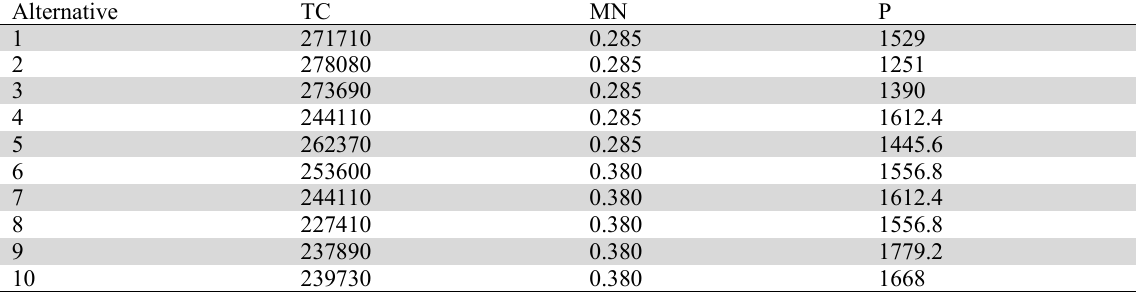
The weighted decision matrix